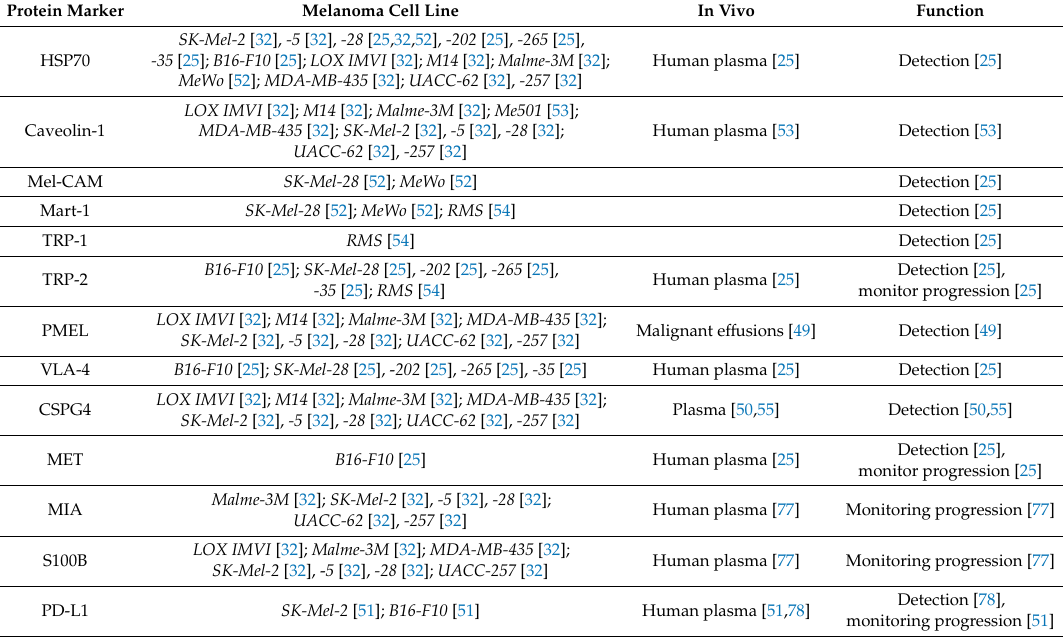
Table 2. Summary of potential melanoma-derived EV protein markers as described in this